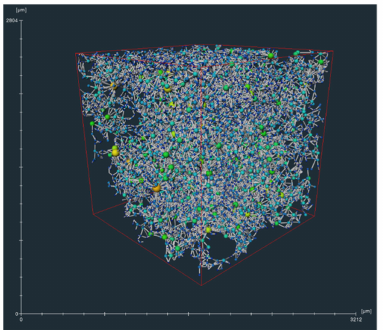
Figure 2. Idealized pore network model extracted from the micro-CT